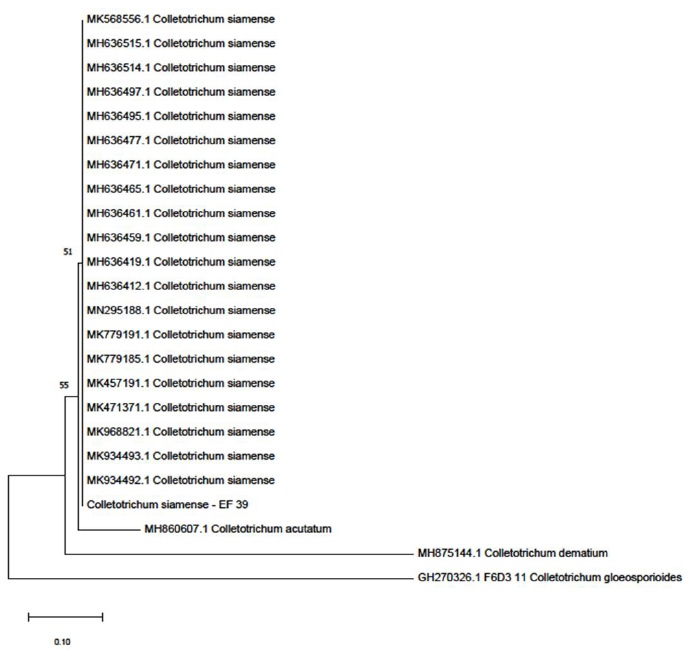
Figure 3. Phylogenetic analysis of ITS sequence of C. siamense and reference isolates.